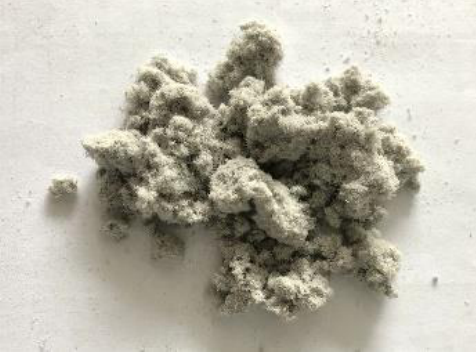
Figure 2. Macro image of lignin fiber.